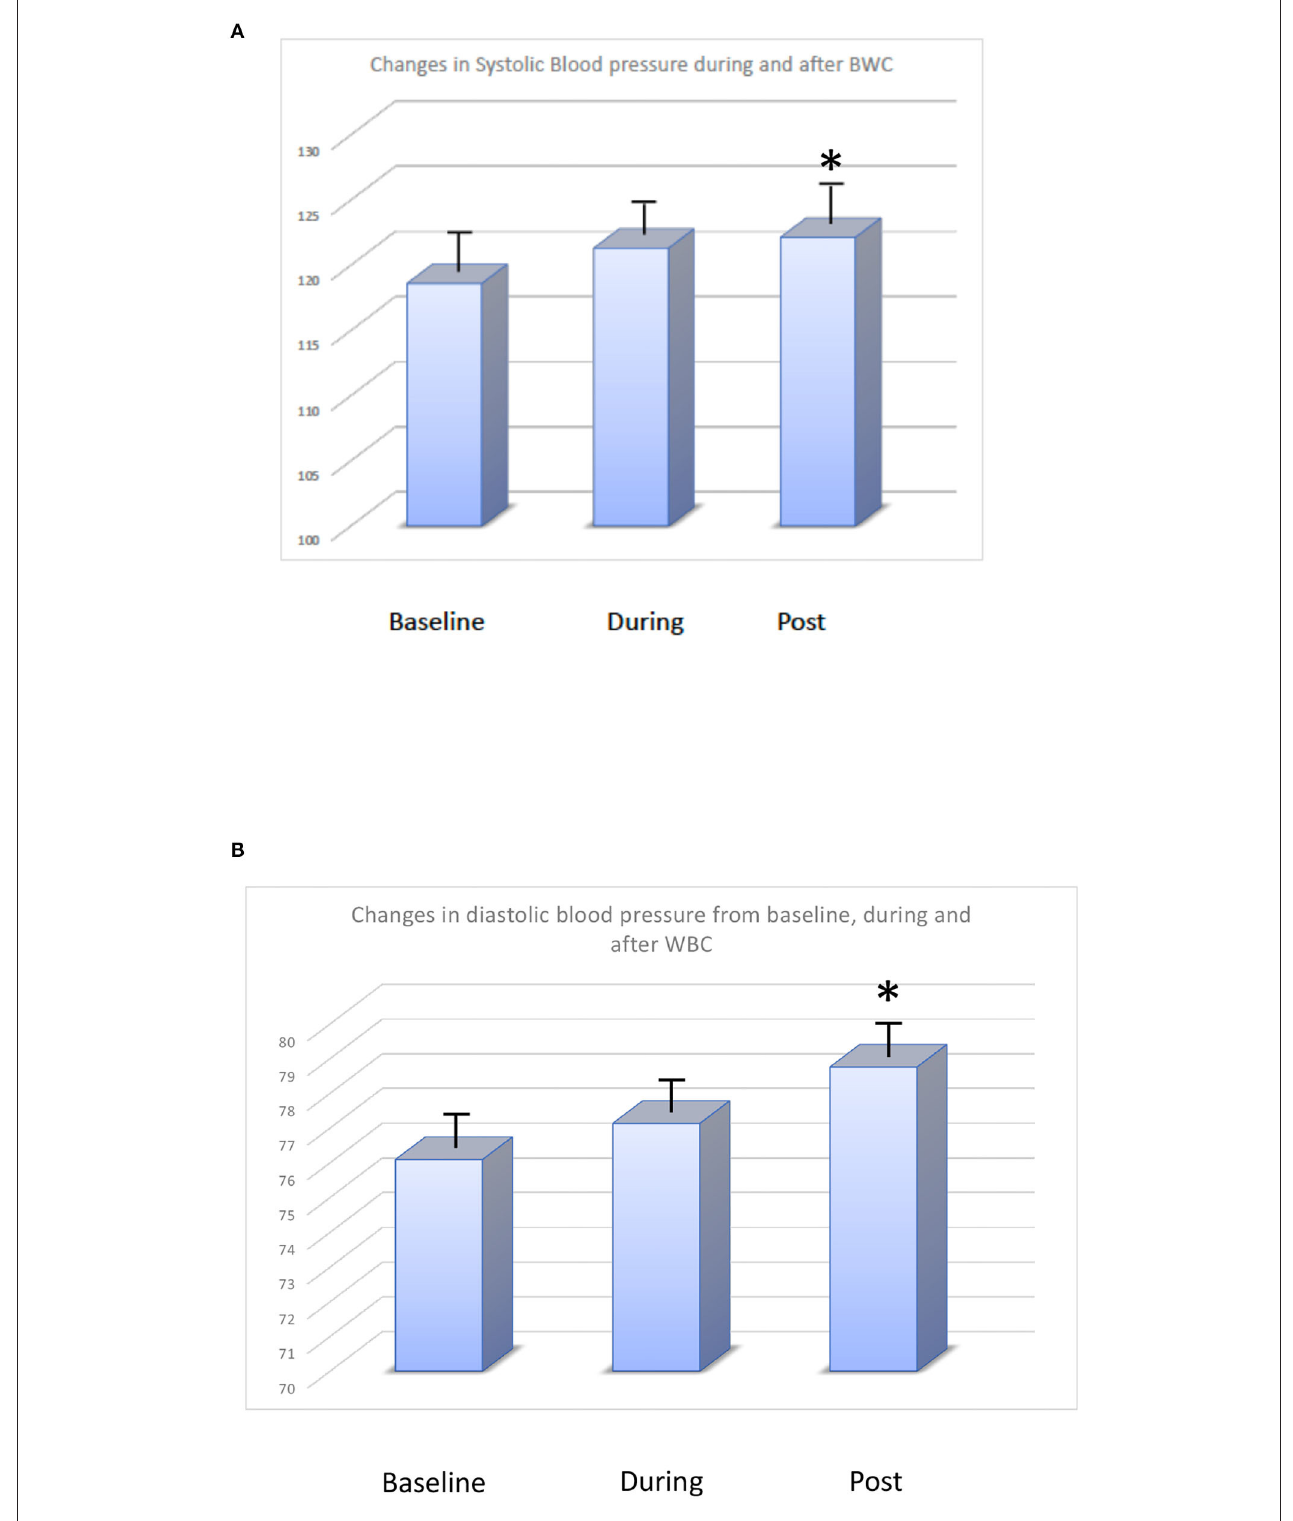
FIGURE 2 | (A) Changes in systolic blood pressure (mmHg) at baseline, during, and after WBC. (B) Changes in diastolic blood pressure (mmHg) at baseline, during, and after WBC.